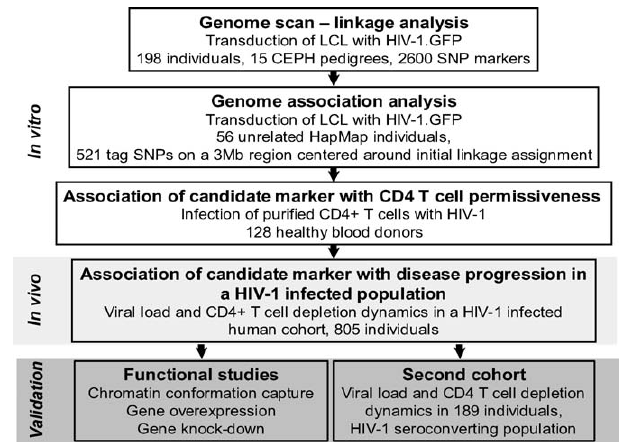
Figure 1. Study Flowchart LCL, lymphoblastoid B cell lines; HIV.GFP, vesicular stomatitis virus G protein-pseudotyped HIV-1-based vector; CEPH, Centre d’Etude du Polymorphisme Humain; SNP, single nucleotide polymorphism.